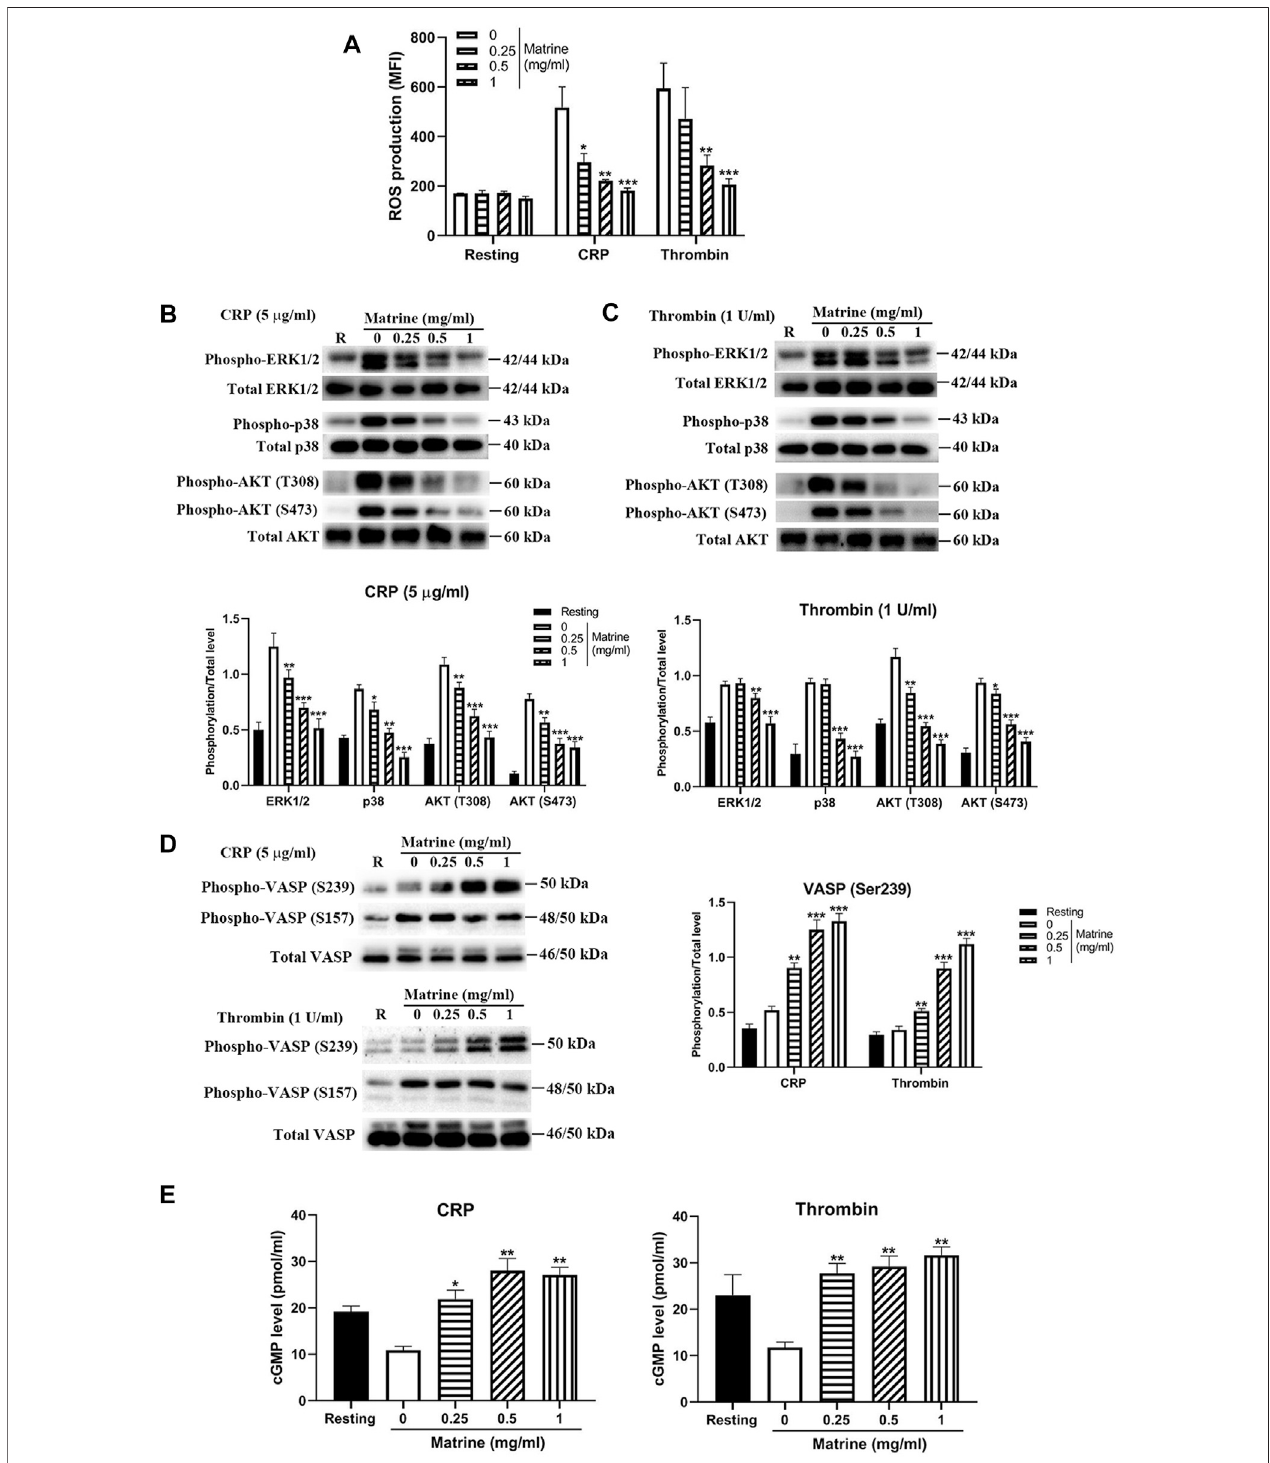
FIGURE 6 | ROS generation, phosphorylation of ERK1/2, p38, AKT and VASP and cGMP level. After matrine treatment, platelet ROS generation was measured usingH2DCF-DAby fl owcytometry (A) .Matrine-treatedplateletswerestimulatedwith5 μ g/mlCRPor1 U/mlthrombinfor5 mintomeasurethephosphorylationlevelof ERK1/2, p38, AKT (B and C) or VASP (D) by western blot (mean ± SD, n (cid:2) 3), cGMP level by ELISA (mean ± SE, n (cid:2) 3) (E) . Compared with 0, * p < 0.05; ** p < 0.01; *** p < 0.001.